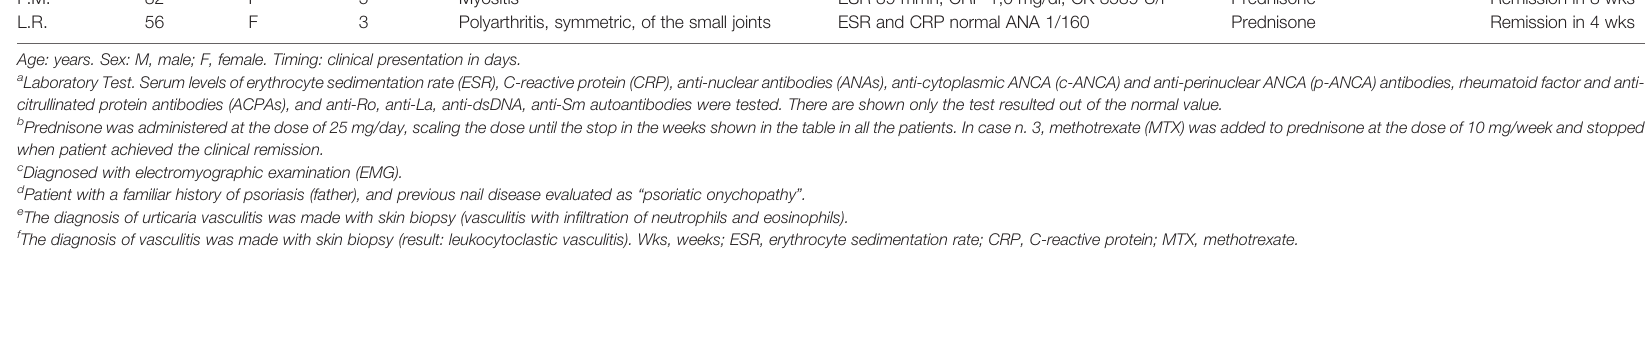
TABLE 5 | Immune-Mediated Diseases (IMDs) fl ared after COVID-19. Case Age Sex Timing Clinical Presentation* Laboratory Test a Therapy b Outcome L.B. E.G. 61 2 Flare of Ankylosing Spondylitis ESR and CRP above the normal values Prednisone + bDMARD Remission in 6 wks A.M.T.